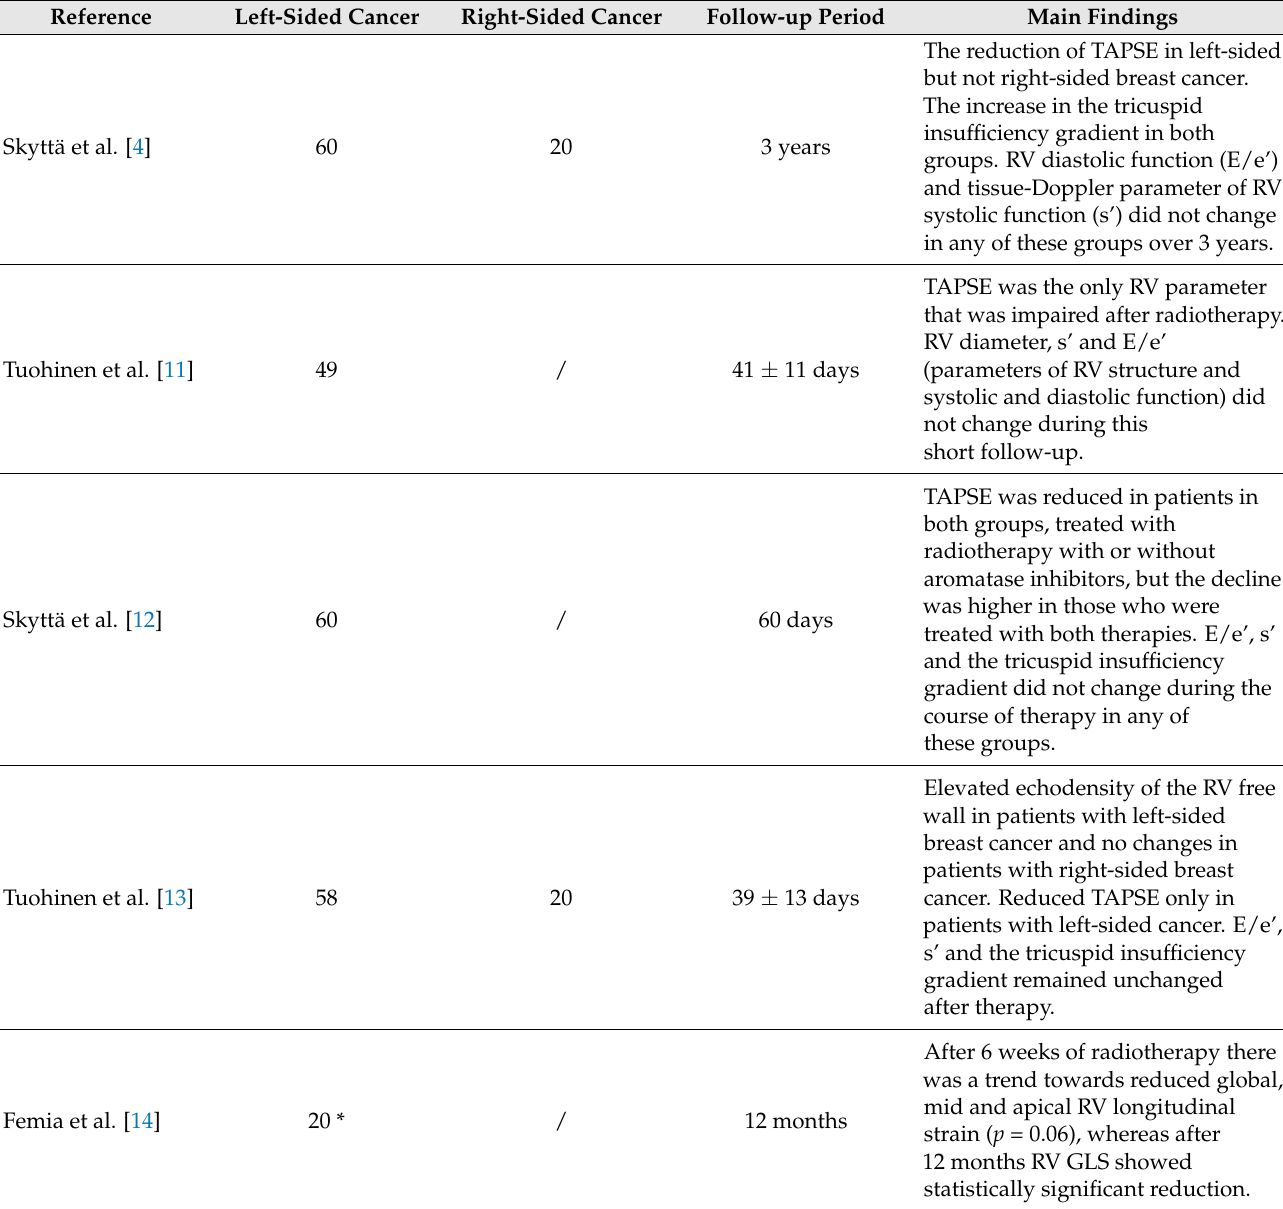
Table 1. RV remodeling in patients with breast cancer after